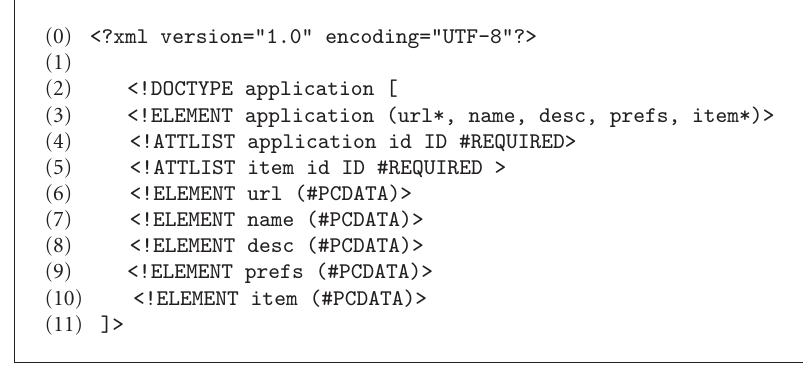
Figure 5: User preferences specification: the DTD.